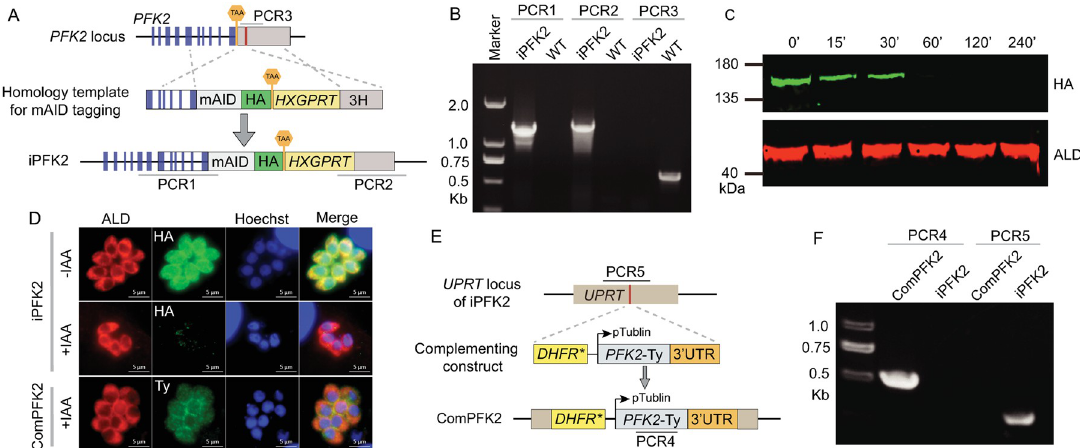
Fig 3. Construction of a PFK2 depletion strain and a corresponding complementation strain. A : The strategy used to construct the conditional depletion strain iPFK2, which had a mAID-HA tag fused to its C-terminus at its endogenous locus. The red bar indicates the CRISPR targeting site. B : Diagnostic PCRs of an iPFK2 clone. The WT is the parental strain RH/Tir1. C : Western blots checking the degradation of PFK2 over time (from 0 to 240 minutes) in the iPFK2 strain after IAA treatment. PFK2 was detected by an HA antibody, whereas ALD was included as a loading control. D : Immunofluorescent staining examining the expression of PFK2 in the depletion and complementation strains. E : Diagram showing the strategy to construct the PFK2 complementation strain ComPFK2, which had a second copy of PFK2 expressed from the UPRT locus. The red bar indicates the CRISPR targeting site. F : Diagnostic PCRs of a ComPFK2 clone.